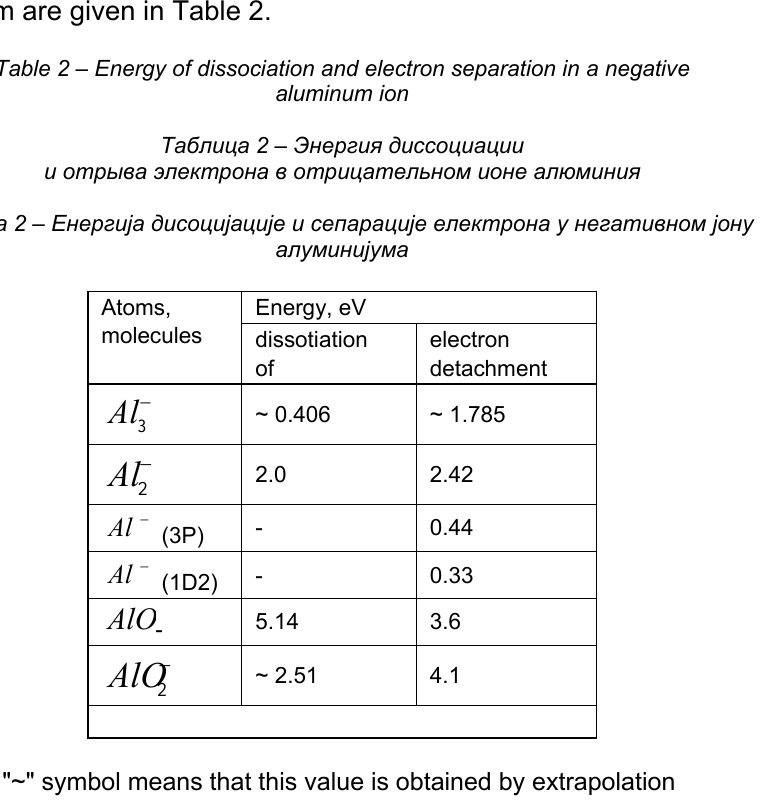
Table 2 – Energy of dissociation and electron separation in a